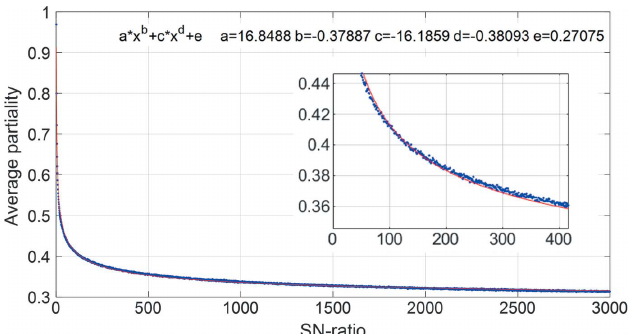
Figure 10 Simulated average partiality as a function of SNR. Simulated binned data points shown in blue. Each bin contains 10 6 data points. A decent fit (red line) is obtained with the power law equation shown in the top of the plot. As shown in the inset, the fit is not flawless, but as the correction of the partiality correction is only meant to speed up the post-refinement process, the fit does not need to be